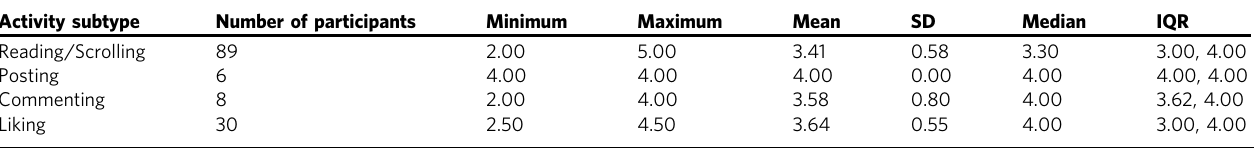
Table 2 Descriptives of feeling scores per social media activity subtype.